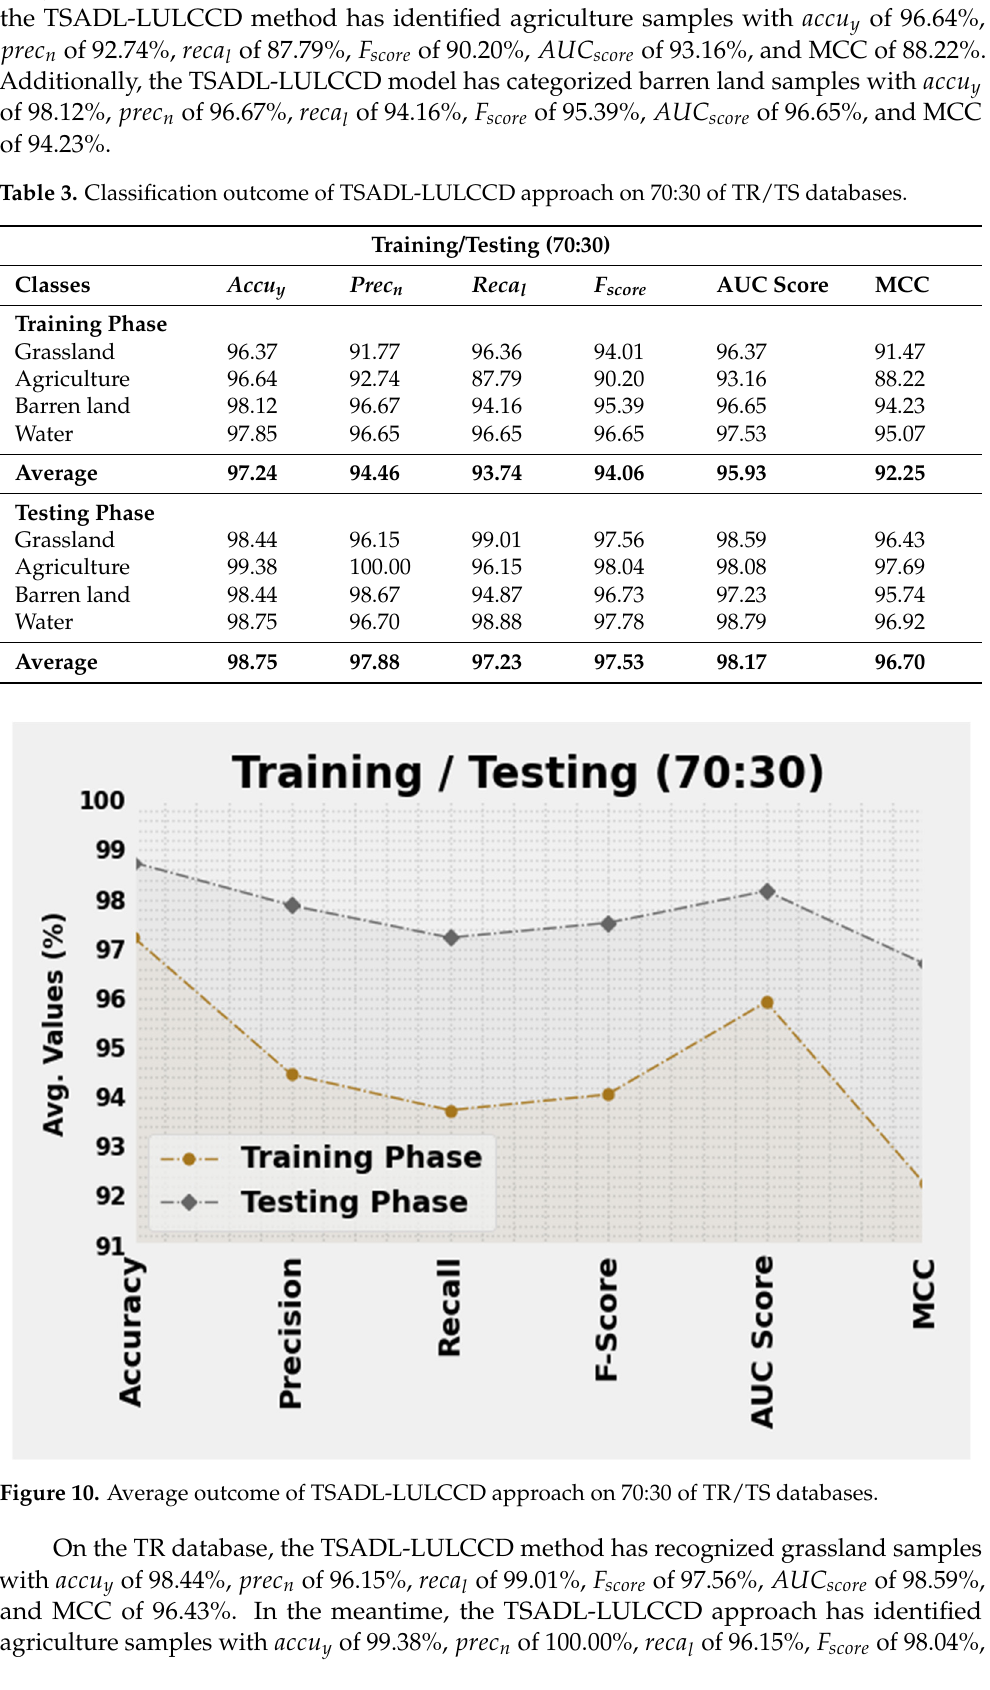
Figure 11. TACC and VACC analysis of TSADL-LULCCD approach on 70:30 of TR/TS database.